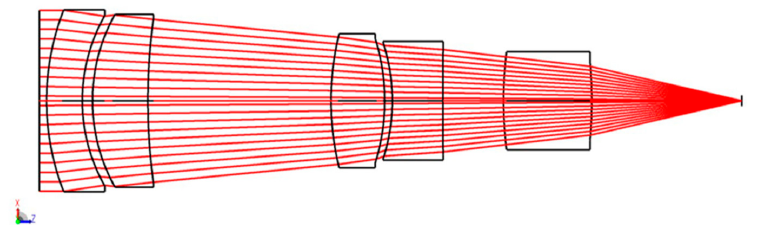
Remote Sens. 2022 , 14 , x FOR PEER REVIEW 9 of 36 Figure 6. The internal optical structure of a single tube of the multi ‐ angle front telescope.